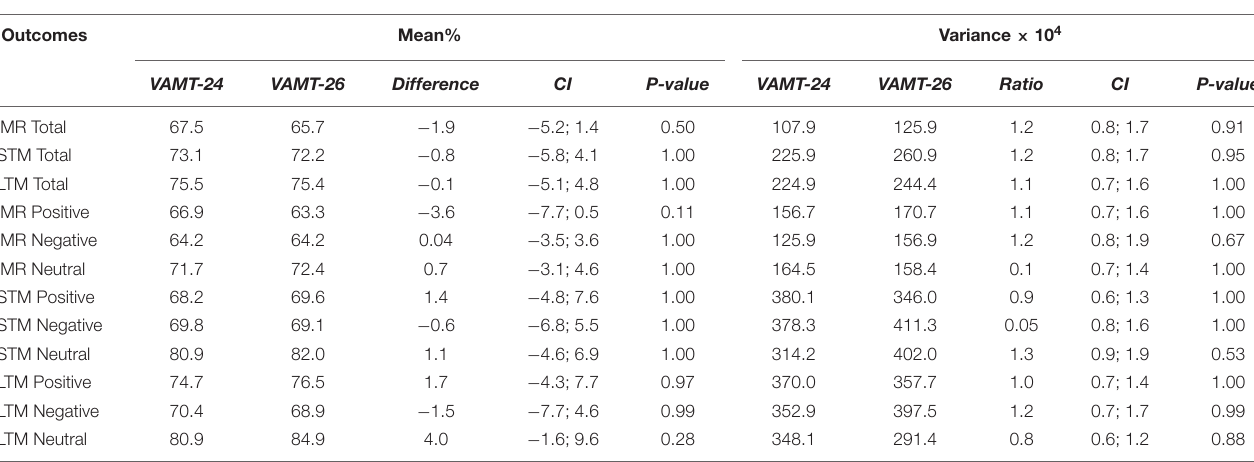
TABLE 4 | Modeled means and variances for VAMT-24 and